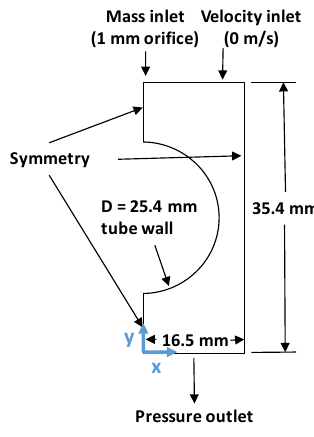
Figure 1. 2D geometry with boundary conditions.